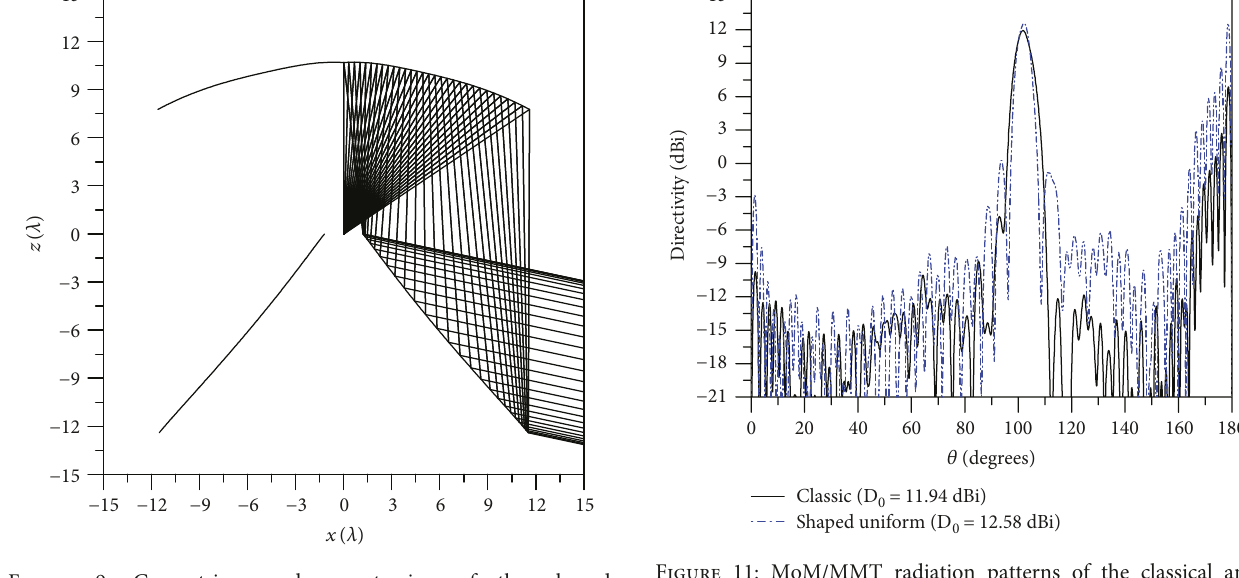
Figure 9: Generatrices and ray tracing of the shaped omnidirectional ADC